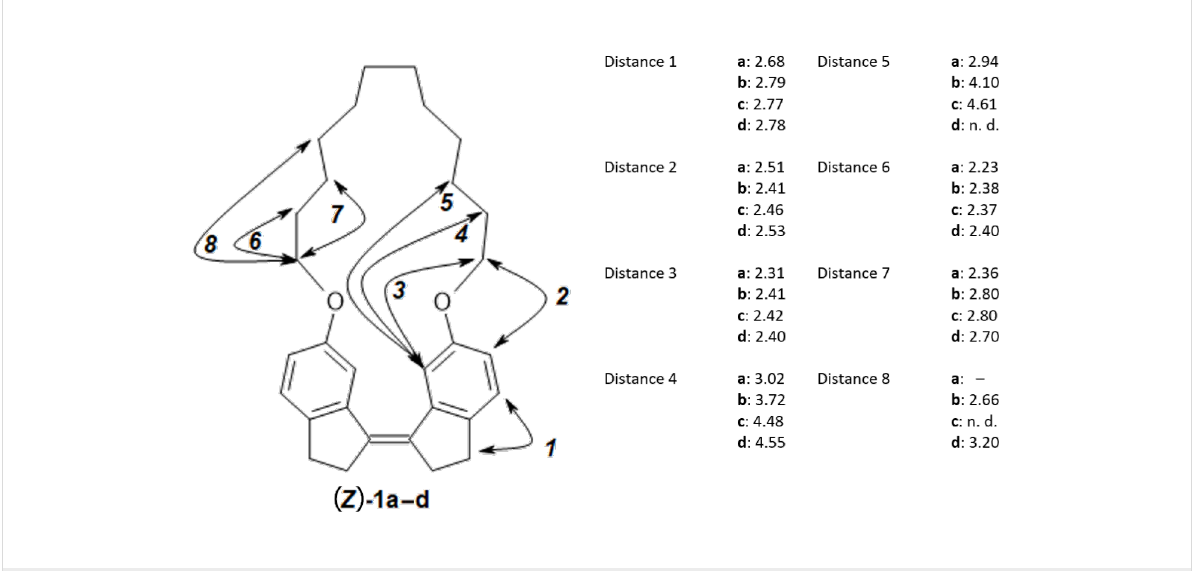
Interatomic distances from NOE buildup